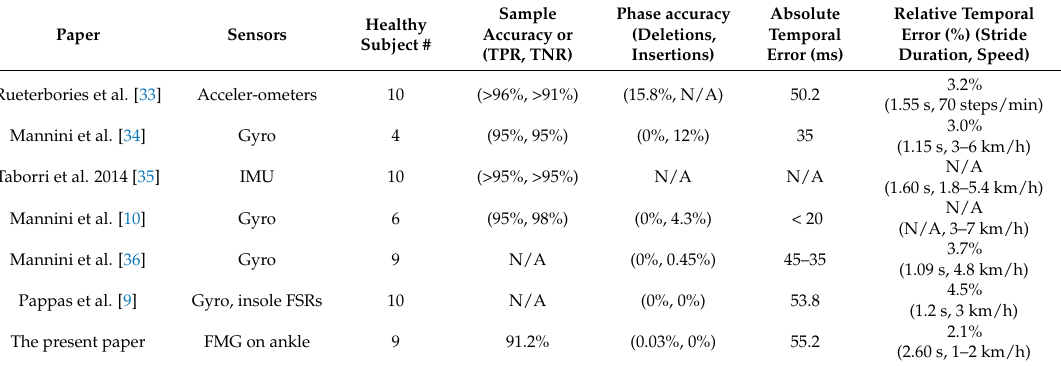
Table 2. Performance of several gait phase detection systems reported in the literature. The number of gait phases considered in these papers is four. The relative temporal error is calculated by dividing the absolute temporal error to the stride